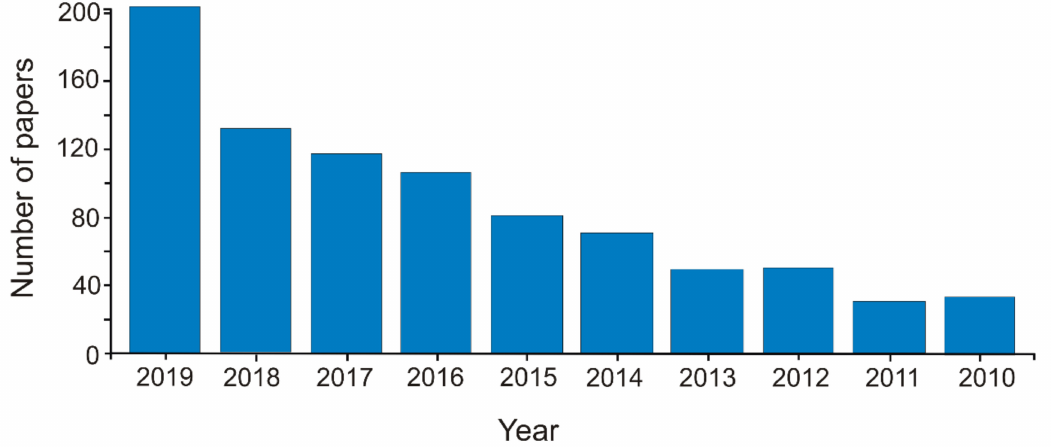
Figure 1. The number of articles published per year in the last decade on the topic of carbonaceous nanomaterials used for developing